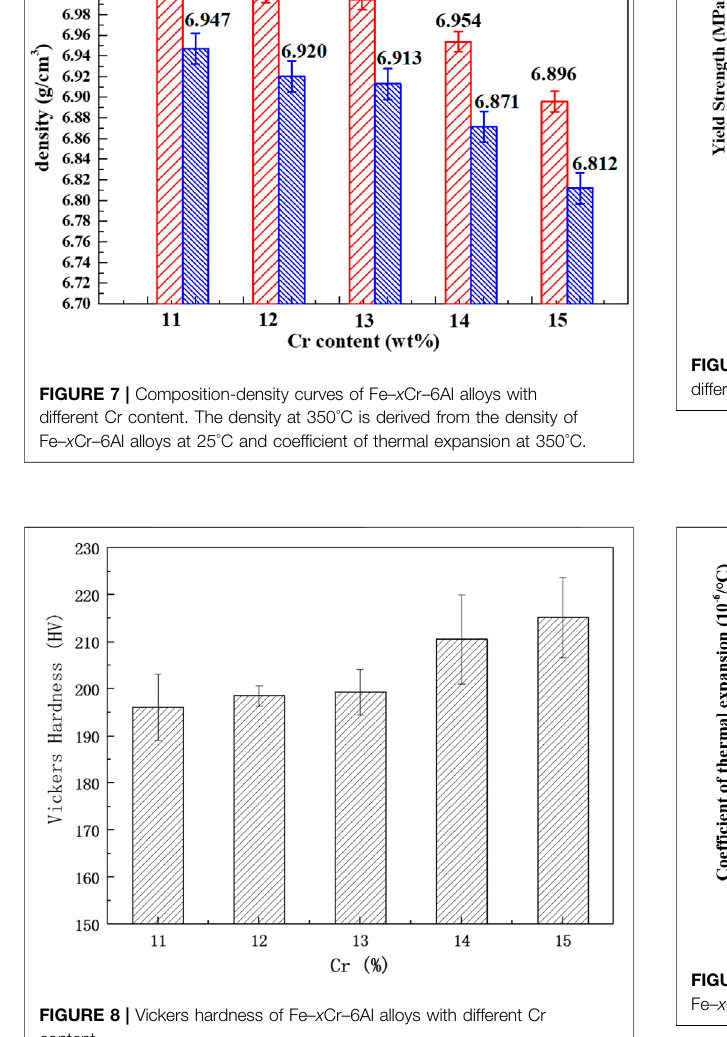
FIGURE 8 | Vickers hardness of Fe – x Cr – 6Al alloys with different Cr content.